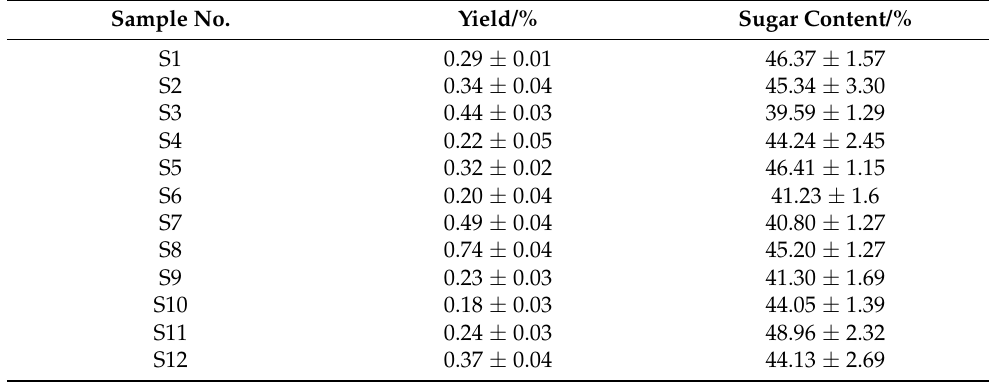
Table 1. The yield and sugar content of the isolated polysaccharide fractions. Sample No.